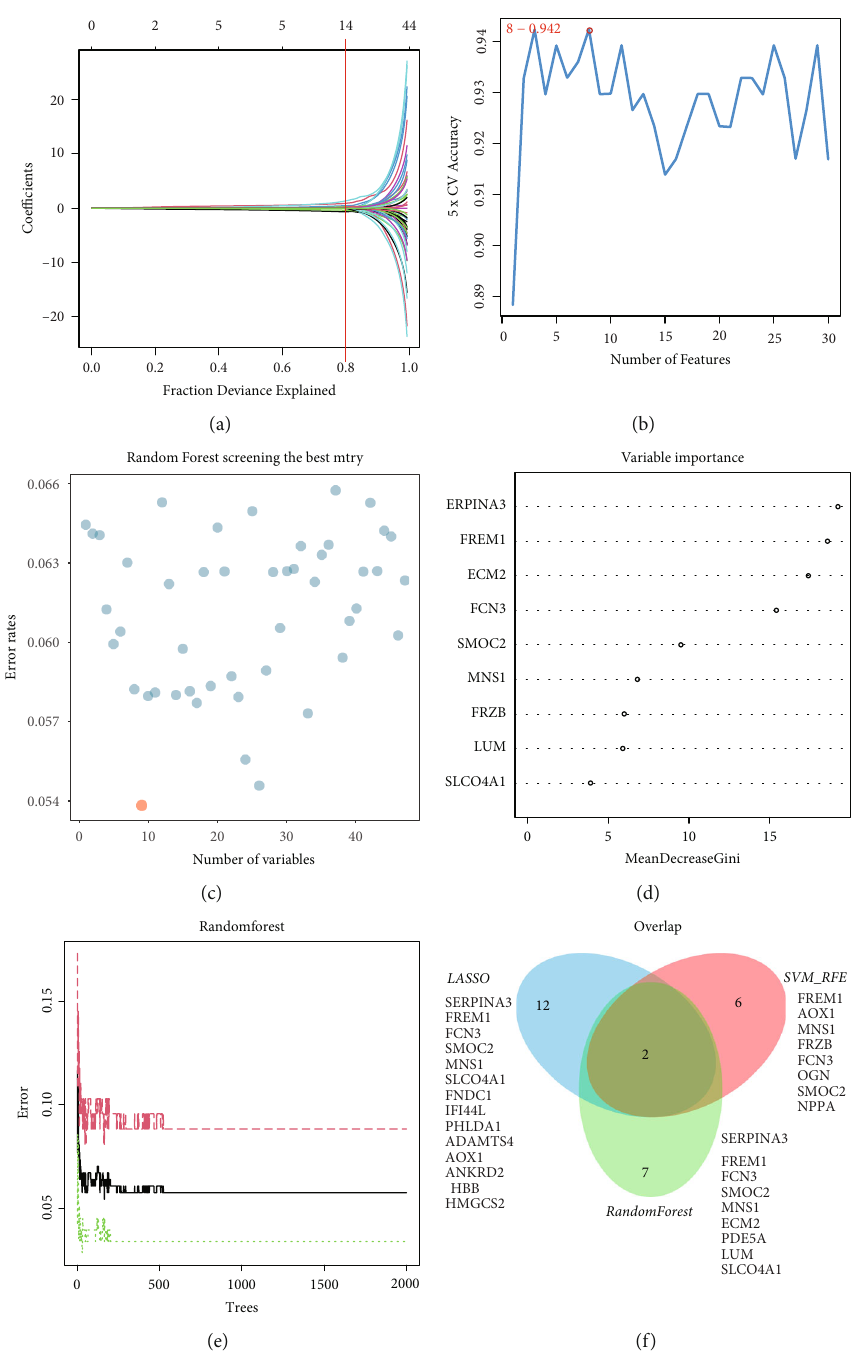
Figure 3: Machine learning algorithms determine genetic signals. (a) LASSO algorithm. LASSO selects 14 gene signals; (b) SVM-RFE algorithm. SVM-RFE selects 8 gene signals; (c) RF algorithm selects the best mtry; (d) top nine genes in RF algorithm; (e) ntree in RF algorithm; (f) Venn diagram of the integration of three